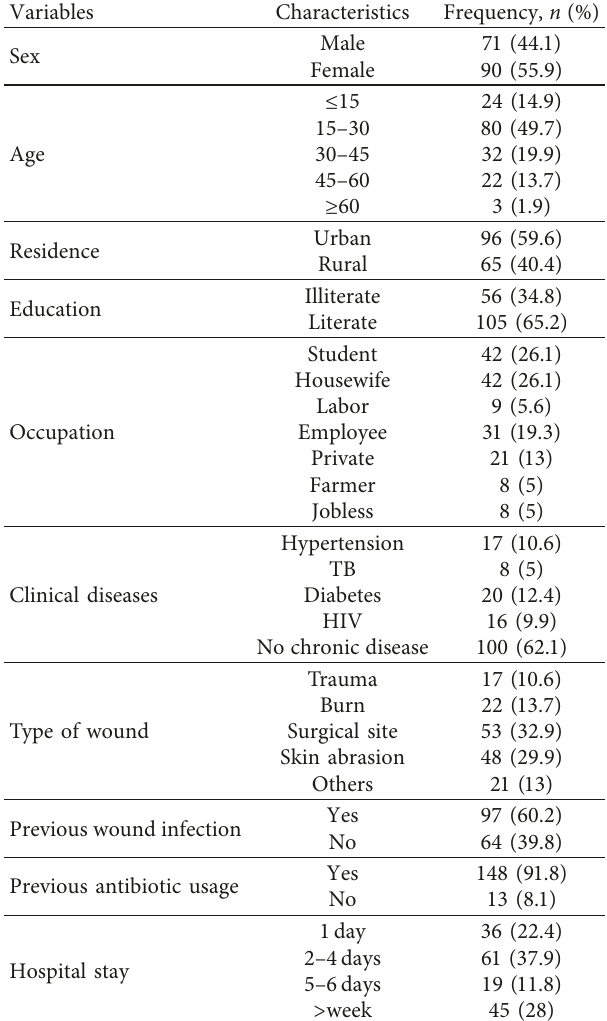
Table 1: Sociodemographic and clinical characteristics of patients with wound infection attending Arba Minch Hospital, Arba Minch, South Ethiopia, April to June